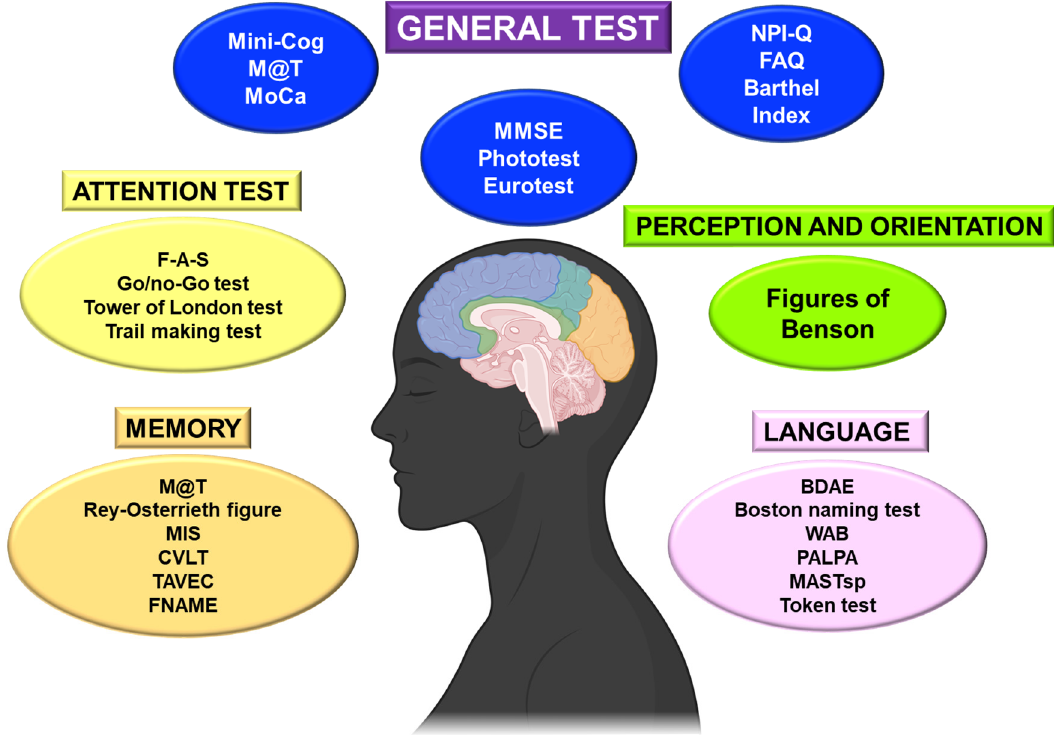
Figure 2. Main tests used to assess cognitive impairment in patients. BDAE: Boston Diagnostic